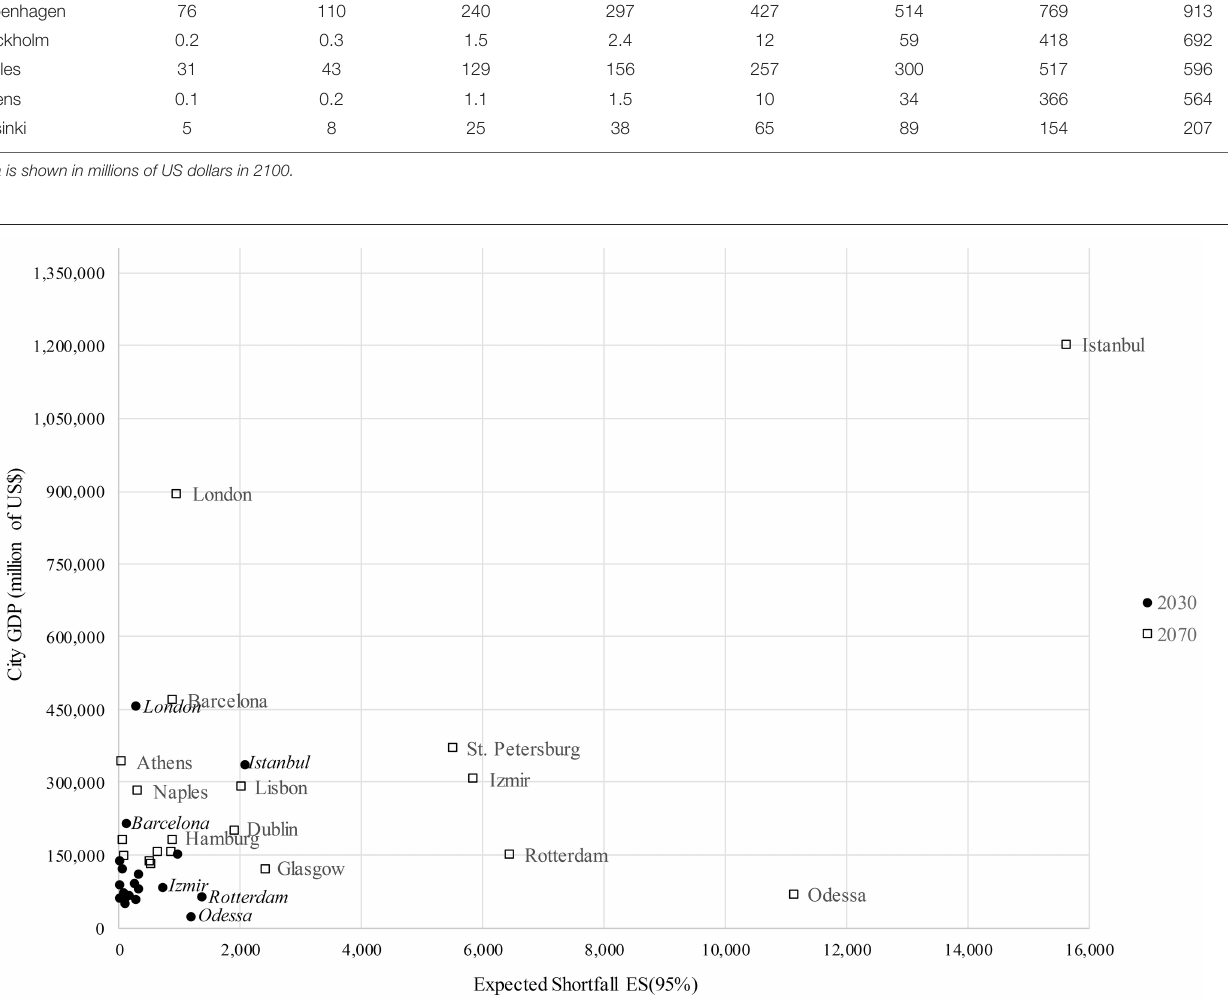
Frontiers in Marine Science |